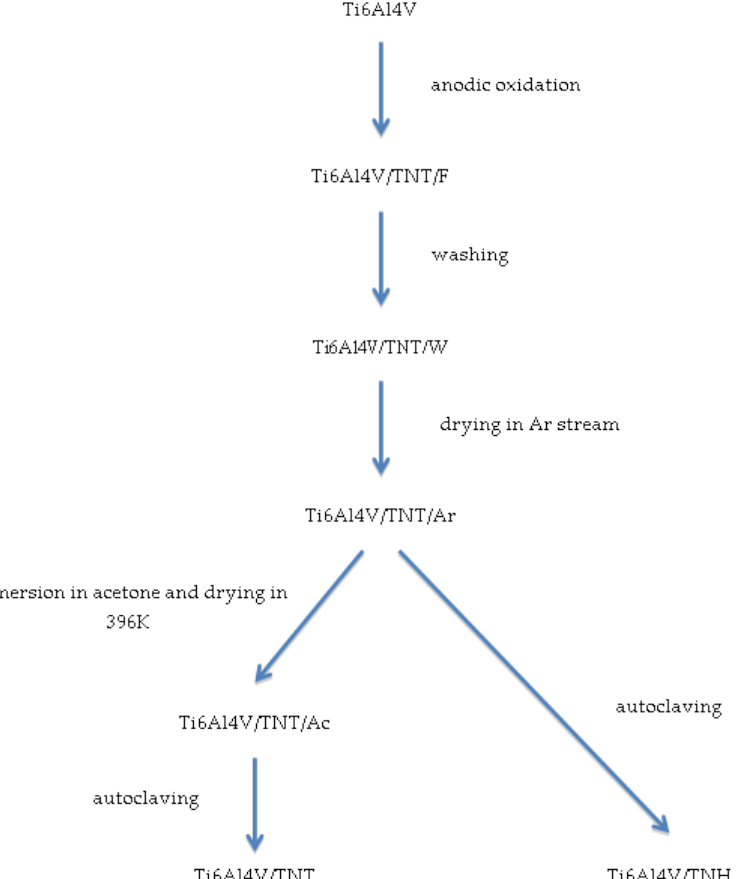
Scheme 1. The scheme of experimental procedure applied in the preparation of the